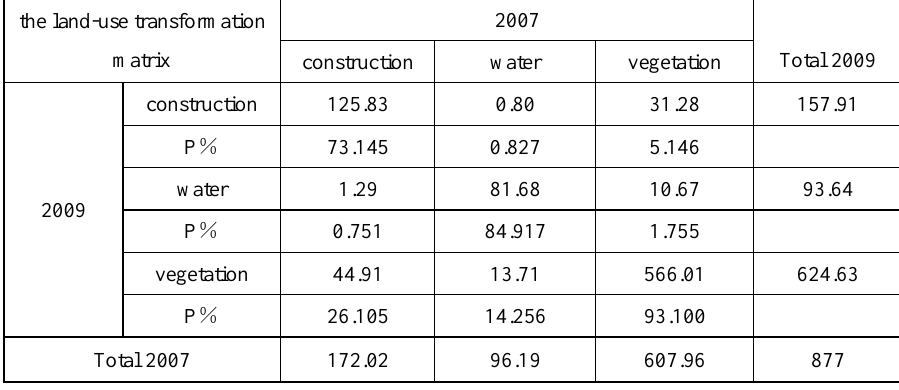
Table 4. The land-use transformation matrix of study area from 2007 to